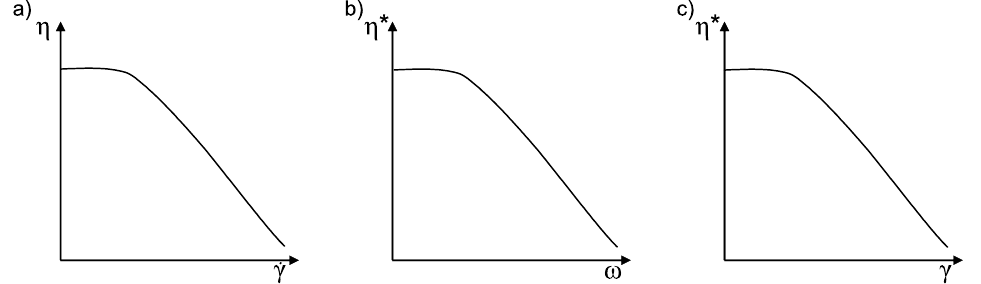
Figure 1. Overview of reported rheological behaviors of MWCNT/polymer suspensions: shear-thinning for: ( a ) steady flow with increasing shear rate (rate-sweep); ( b ) oscillatory flow with increasing angular frequency (frequency-sweep); ( c ) oscillatory flow with increasing strain amplitude